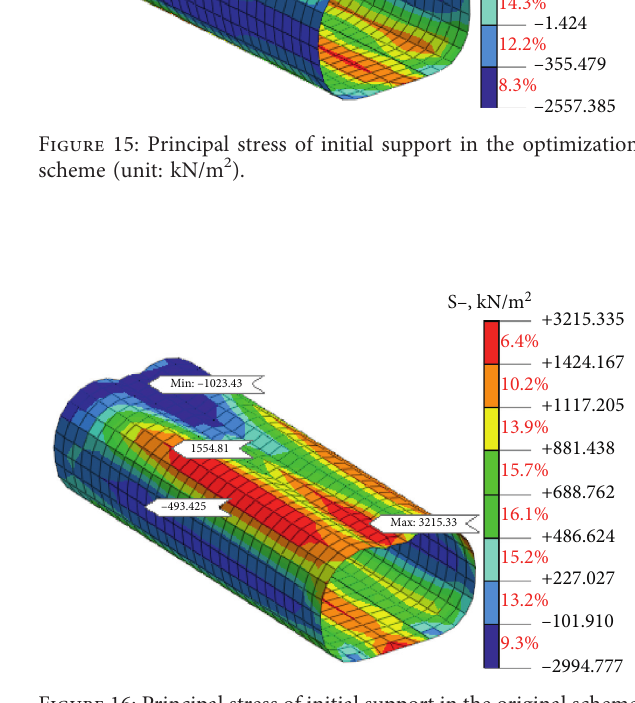
Figure 16: Principal stress of initial support in the original scheme (unit: kN/m 2